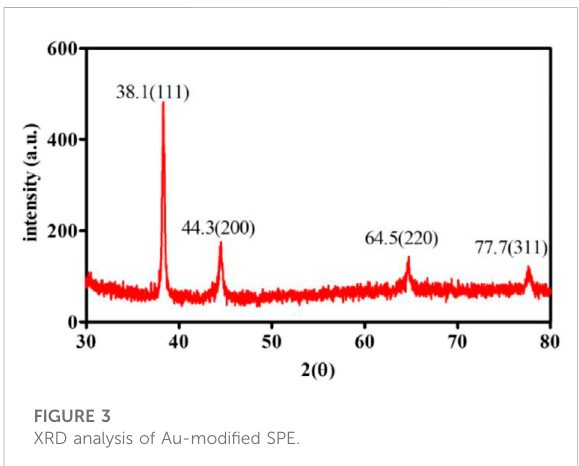
FIGURE 3 XRD analysis of Au-modi fi ed